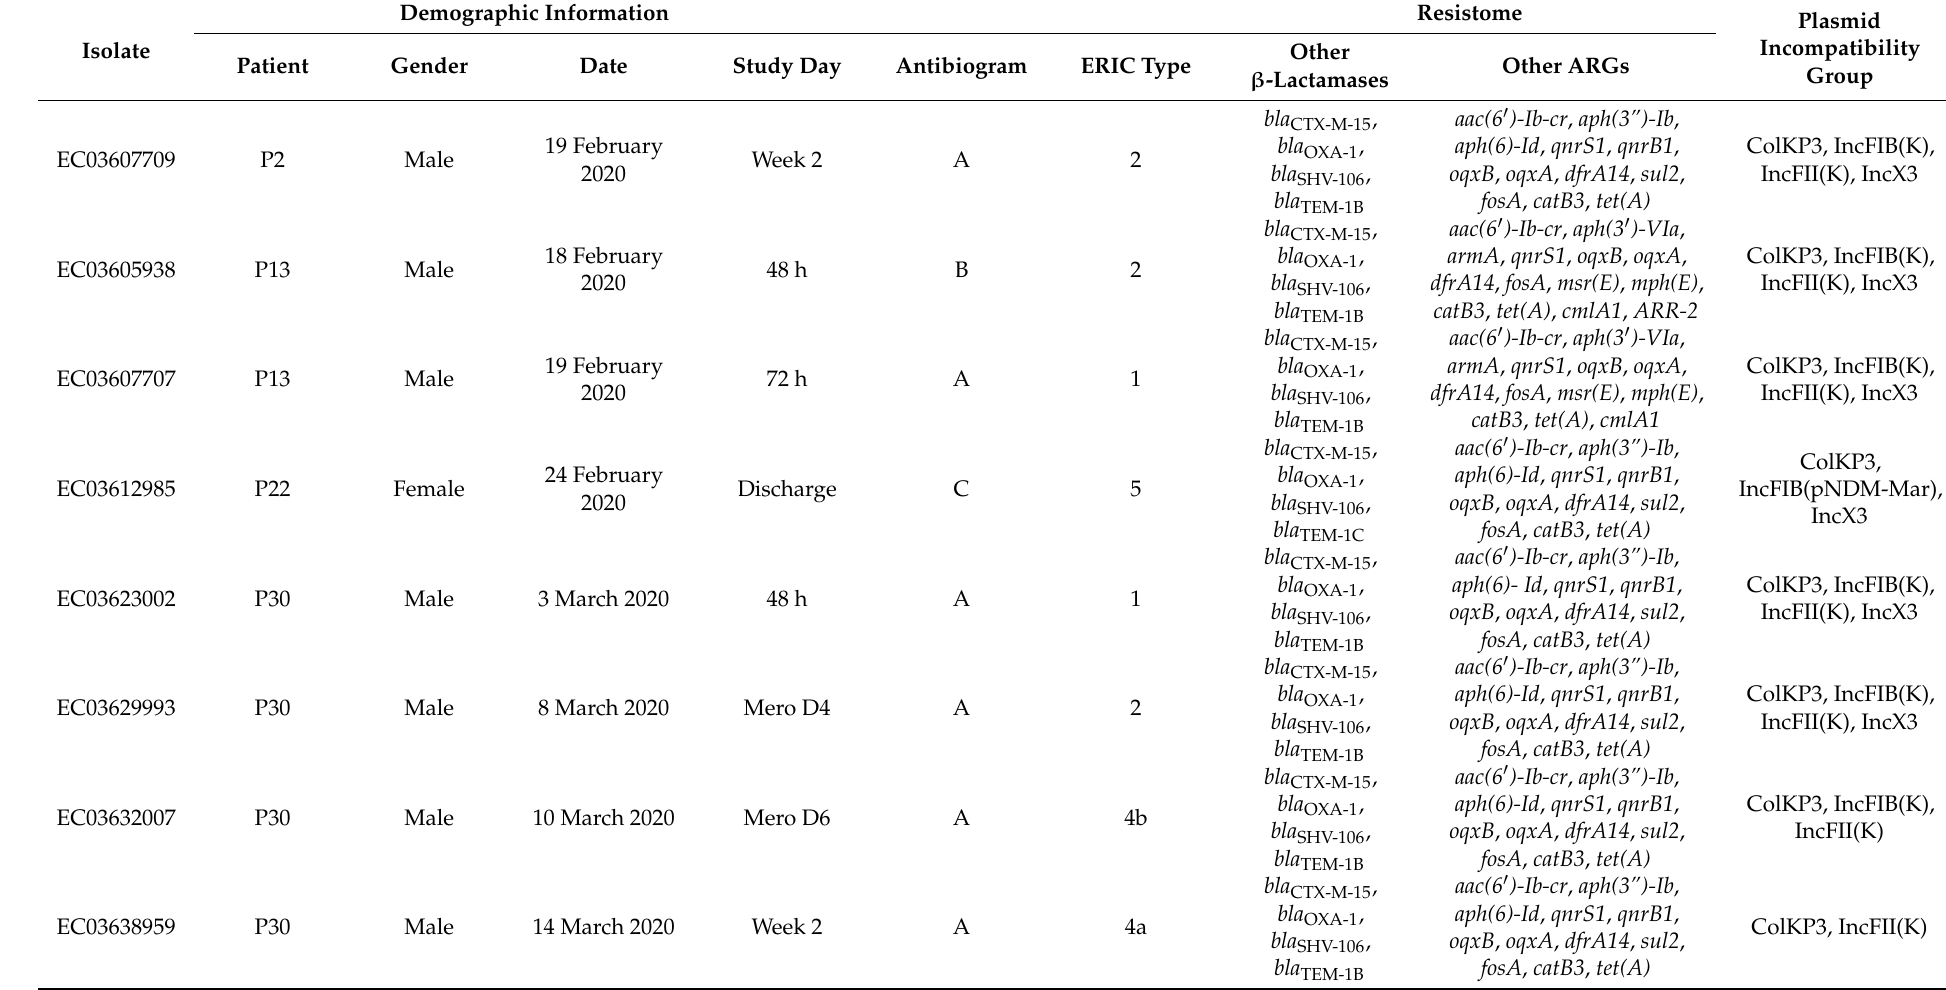
Table 1. Patient demographics, antibiograms, sequence types, carbapenemase, other β -lactamases, and ARGs in K. pneumoniae isolates.